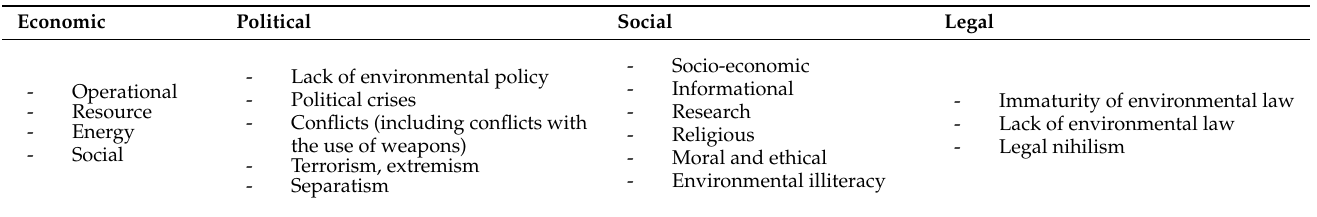
Table 2. Anthropogenic environmental hazards classification in the development of the Arctic